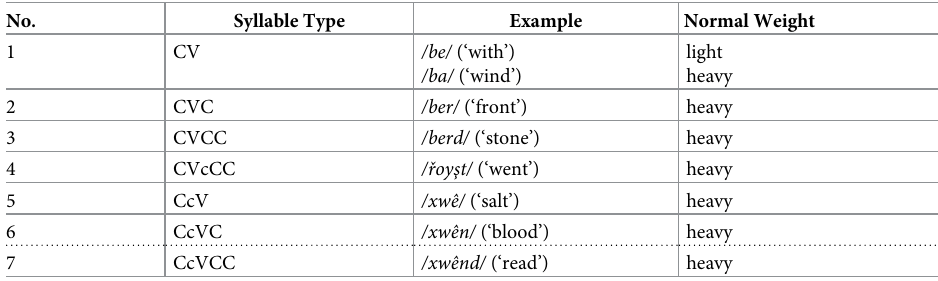
Table 3. Syllable Types in Standard Central